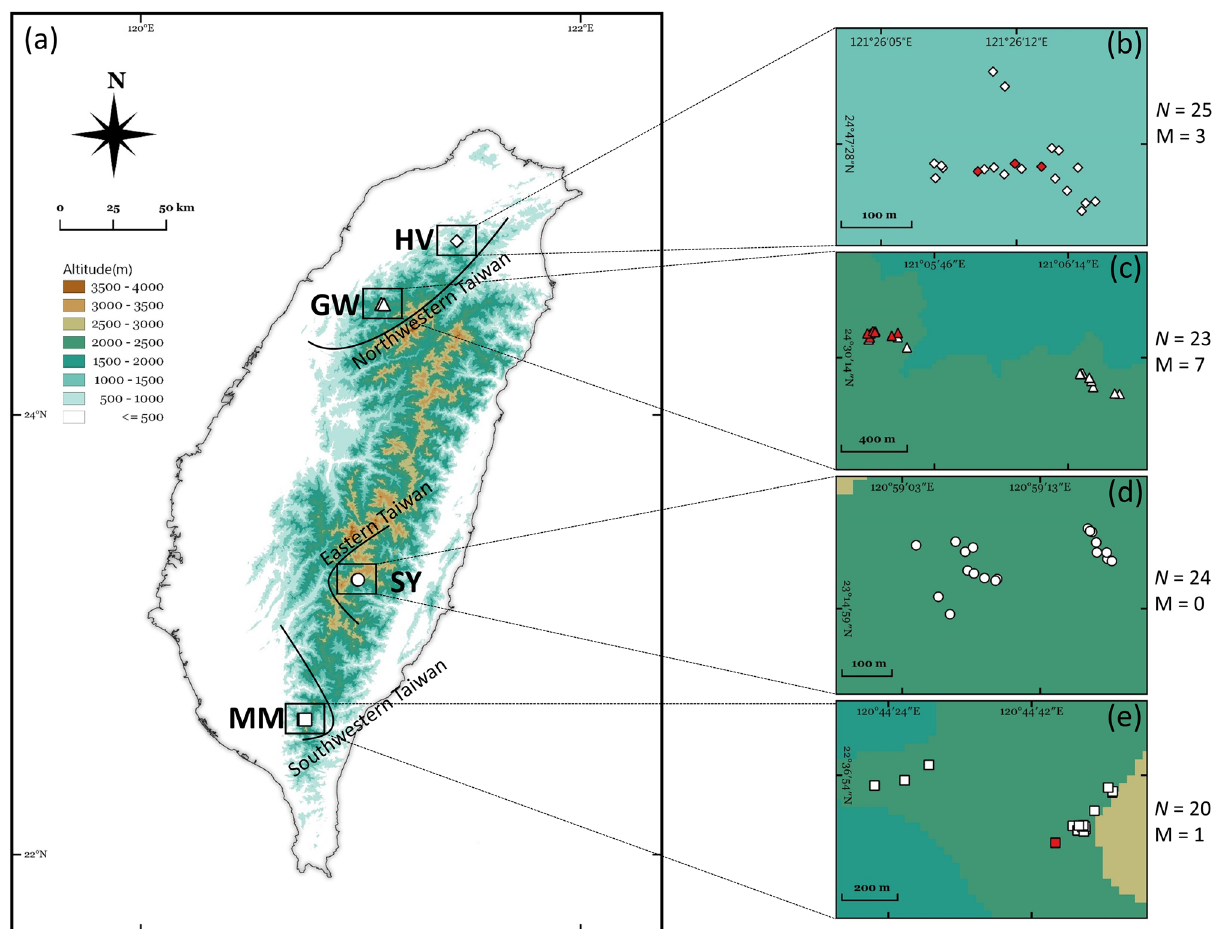
Figure 2. The biogeographic information of Chamacyparis formosensis in this study. A total of 92 samples composed of 20 MM, 25 HV, 23 GW, and 24 SY individuals were analyzed ( a ) Biogeographic analysis data suggests that the samples fall into three genetical categories: SY (Eastern Taiwan), HV & GW (Northwestern Taiwan), and MM (Southwestern Taiwan) ( b )–( e ) The red spots represent the individuals that have been mis- assigned (denoted as M in figure legend) from provenance simulation result. N : the number of individuals, M : the number of 0.876, with an average 0.528. The levels of PD range from 0.102 to 0.885, with an average 0.567. The levels of P I range from 0.114 to 0.897, with an average 0.431. There were 19 out of 36 markers with PIC greater than 0.5, and the mean of these 36 markers PIC values was greater than 0.5, suggesting the markers have a high identification ability. The results of PD and P I correspond to those of PIC . The highly informative markers presented in PIC also show higher identification ability in PD and P I . Significant linkages ( P < 0.001) were detected among Cred35/229/277 (Group 1), Cred47/298 (Group 2), Cred231/249/253/262 (Group 3), Cred281/297 (Group 4), Cred603/683 (Group 5) and Cred640/678/682 (Group 6) with GENEPOP 4.2 39 , suggesting the abovementioned group located in the same linkage group (Table 2).